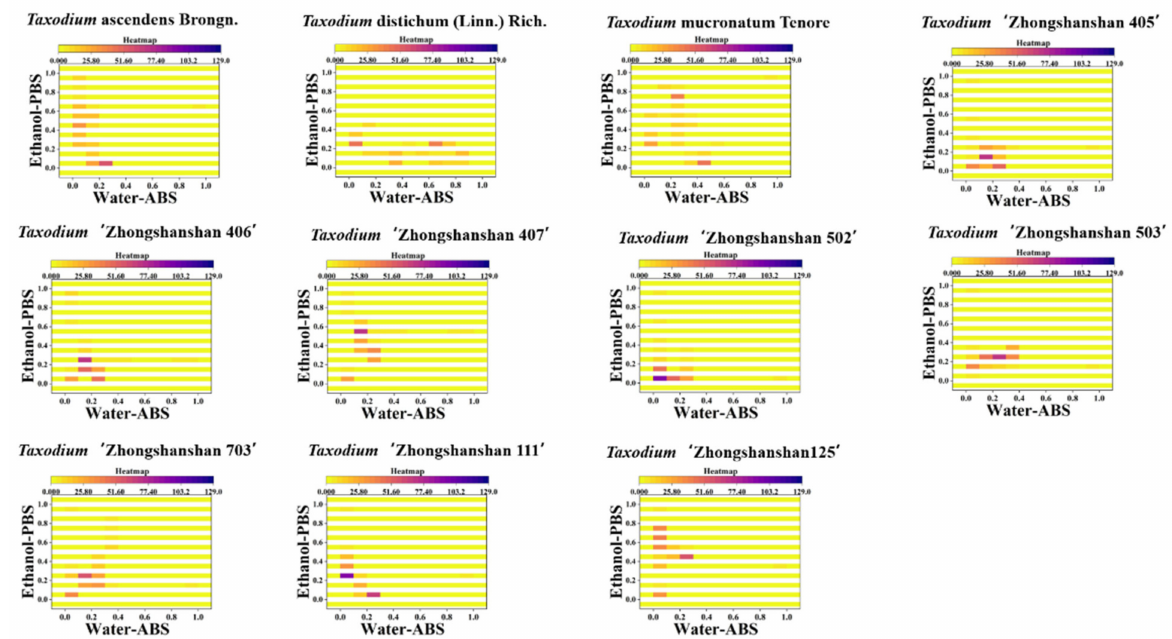
Figure 5. Heatmap of T. ascendens, T. distichum, T. mucronatum, T. ‘Zhongshanshan 405’, T. ‘Zhongshanshan 406’, T. ‘Zhongshanshan 407’, T. ‘Zhongshanshan 502’, T. ‘Zhongshanshan 503’, T . ‘Zhongshanshan 703’, T. ‘Zhongshanshan 111’, and T. ‘Zhongshanshan 125’ combining the signals collected under ABS for the water extracts and under PBS for the ethanol